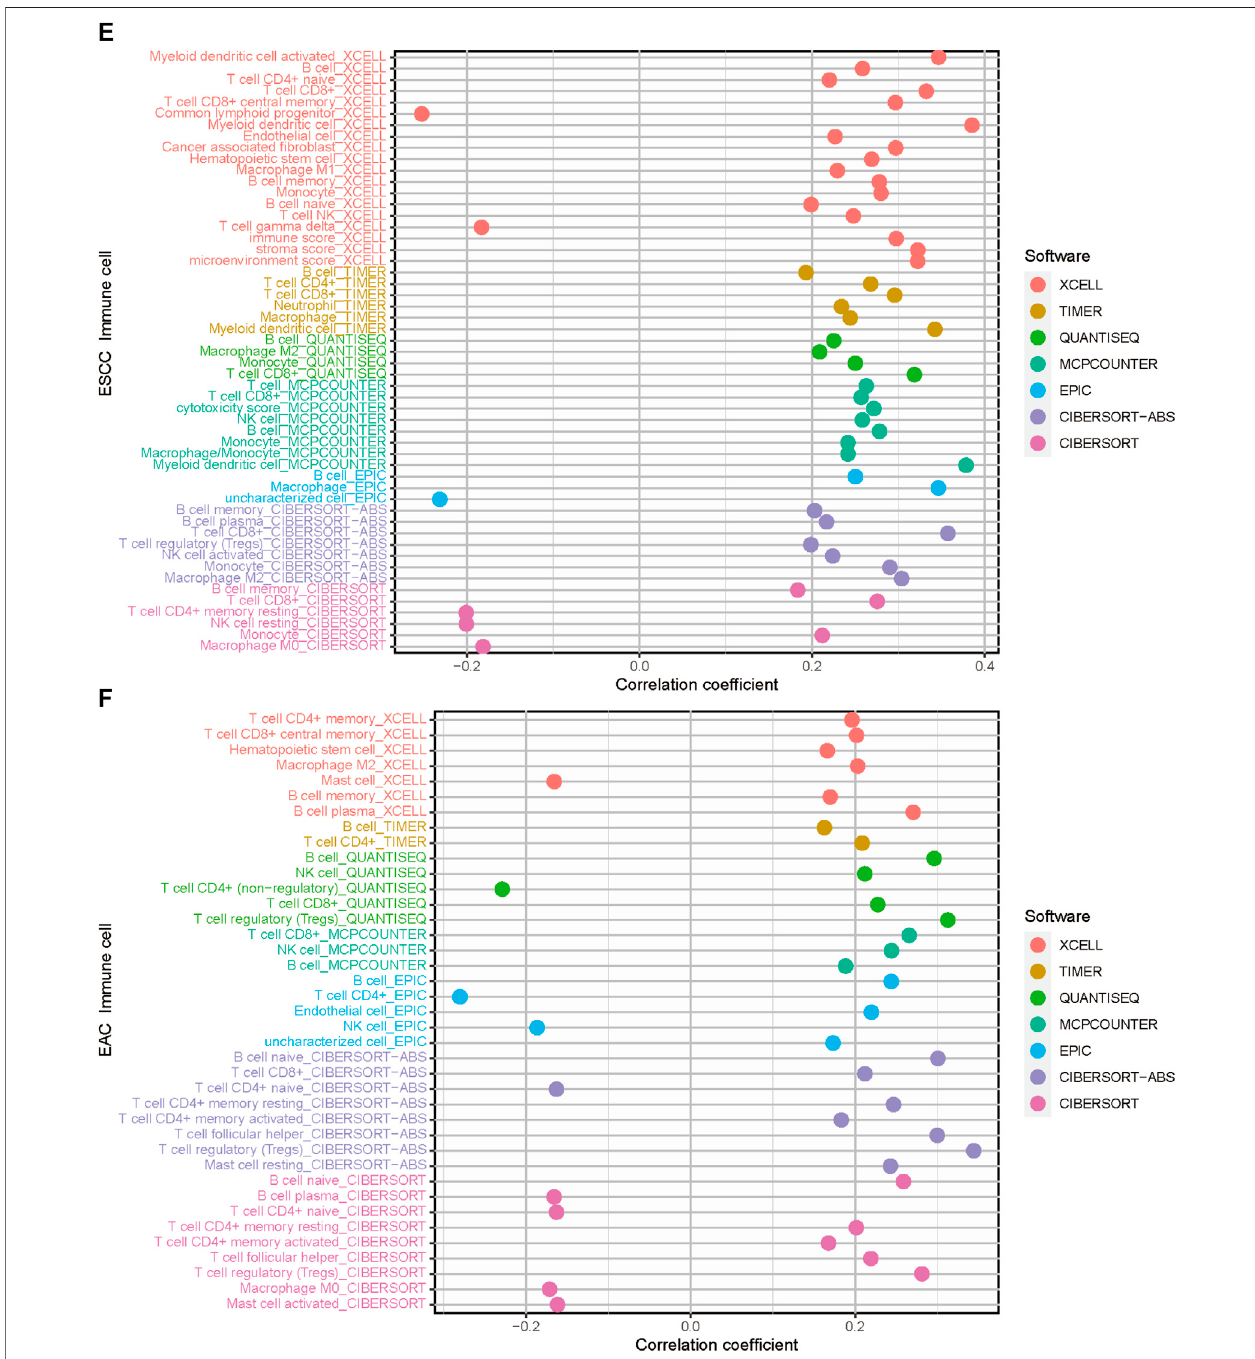
patients, we examined the relationship between risk scores and IC 50 of drugs universally used or studied in the treatment of ESCC and EAC. These agents included cisplatin, sunitinib, erlotinib, ge fi tinib, lapatinib, and sorafenib. As shown in Figures 6A,B ,